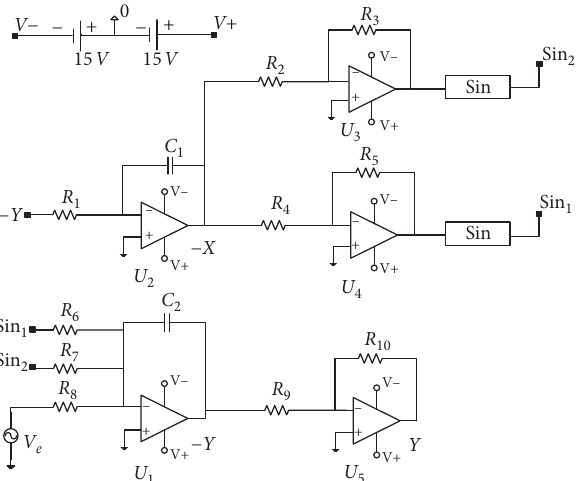
Figure 8: Analog computer of the new Hamiltonian megastable